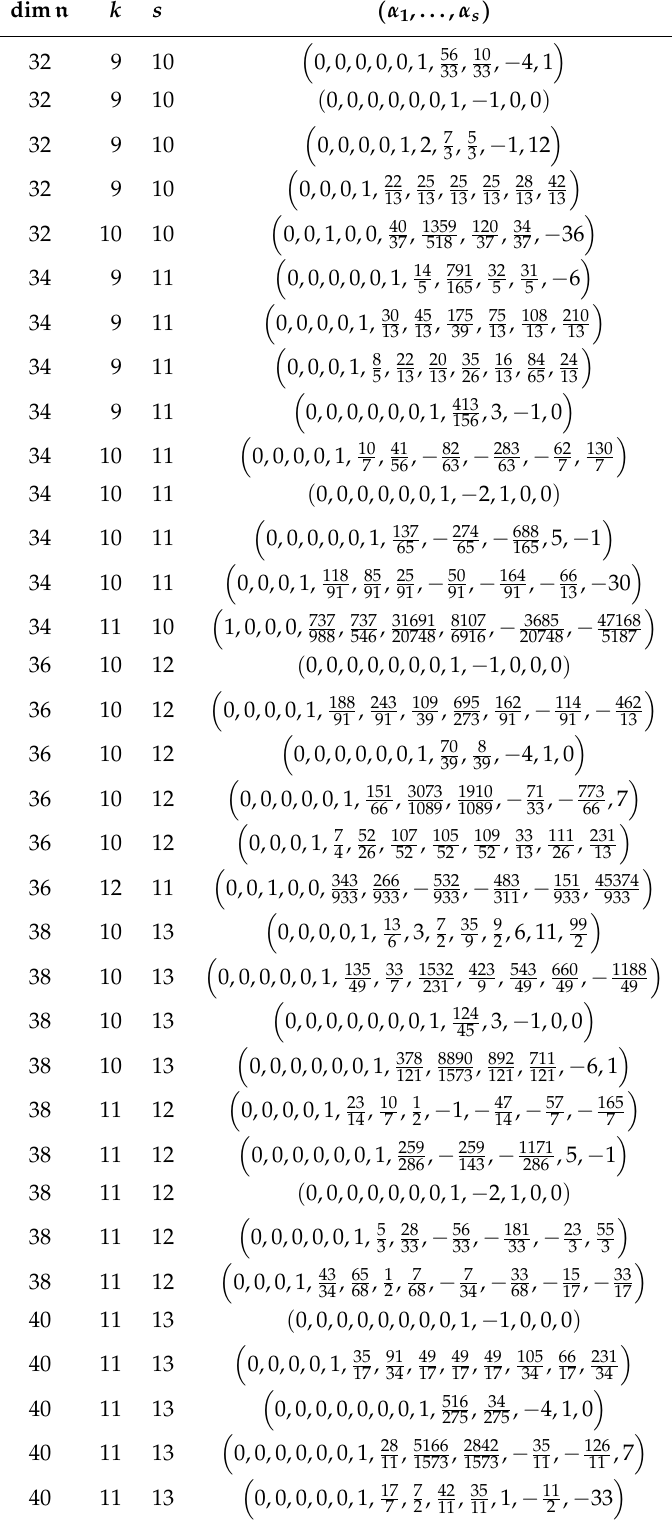
Table 2. Rational cohomological rigid Lie algebras in dimensions 30 < n ≤